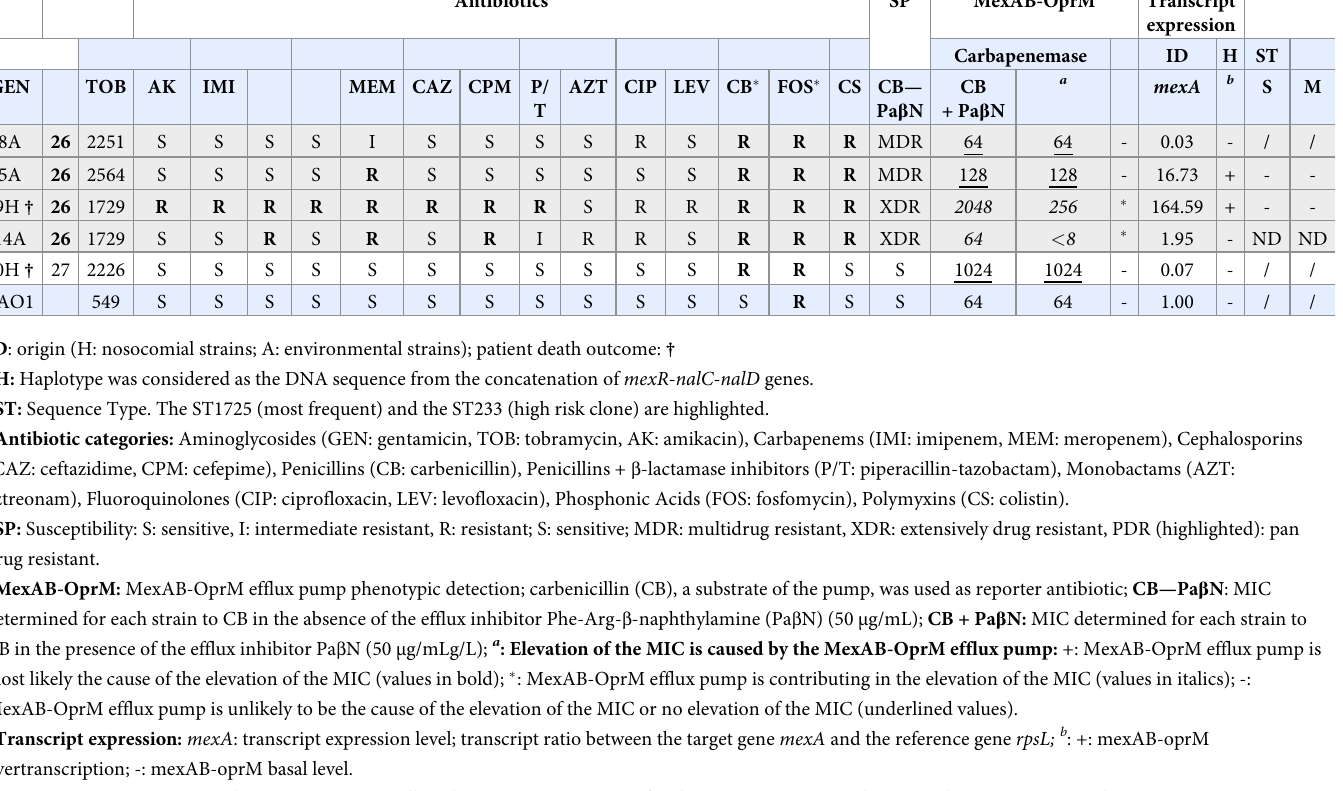
metallo- β -lactamase) was conducted (Table 1) and showed that eight strains were positive for serine carbapenemases, and 11 strains were positive for metallo- β -lactamases. MexAB-OprM efflux pump contributes to MIC rising behavior Of the 91 P . aeruginosa strains, 56.04% [51/91: 9 MDR, 23 XDR, and 19 PDR] demonstrated high phenotypic activity of the MexAB-OprM efflux pump (Table 1). However, the MexA- B-OprM efflux pump was considered as the most likely cause of the elevation of the MIC in 52.9% of the strains [27/51: (4 MDR, 9 XDR, and 14 PDR)]. In 47% of the strains [24/51: (5 MDR, 14 XDR, and 5 PDR)] the MexAB-OprM efflux pump was contributing to the elevation of the MIC. Finally, the MexAB-OprM efflux pump was not the cause of the elevation of the MIC in 43.96% of the strains [40/91: (3 S, 14 MDR, 16 XDR,7 PDR)]. Considering the phenotypic positive-strains (Table 1): a significant difference was observed between nosocomial (64.93%, 50/77) and environmental strains (7%, 1/14) ( p < 0.0001), taking the negative MexAB-OprM efflux pump strains as reference (RRR = 11.07; p = 0.025). In addi- tion, a significant difference was observed between strains classified as PDR (73%; 19/26), XDR (58.97%; 23/39), MDR (39.1%; 9/23) and S (0%;0/3) (p = 0.016), where positive MexA- B-OprM efflux pump strains and taking the MDR strains as reference (RRR = 7; p = 008) (Table